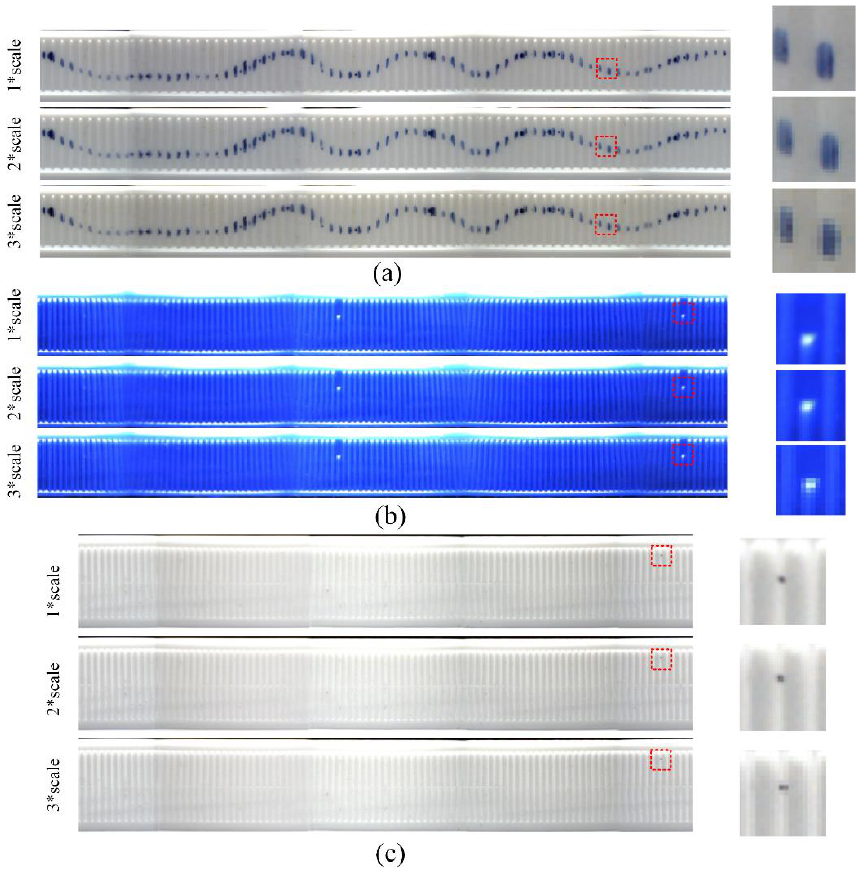
Figure 15. The stitching results: ( a ) The stitching results of the images of the sample 1; ( b ) The stitching results of the images of the sample 2; ( c ) The stitching results of the images of the sample 3.